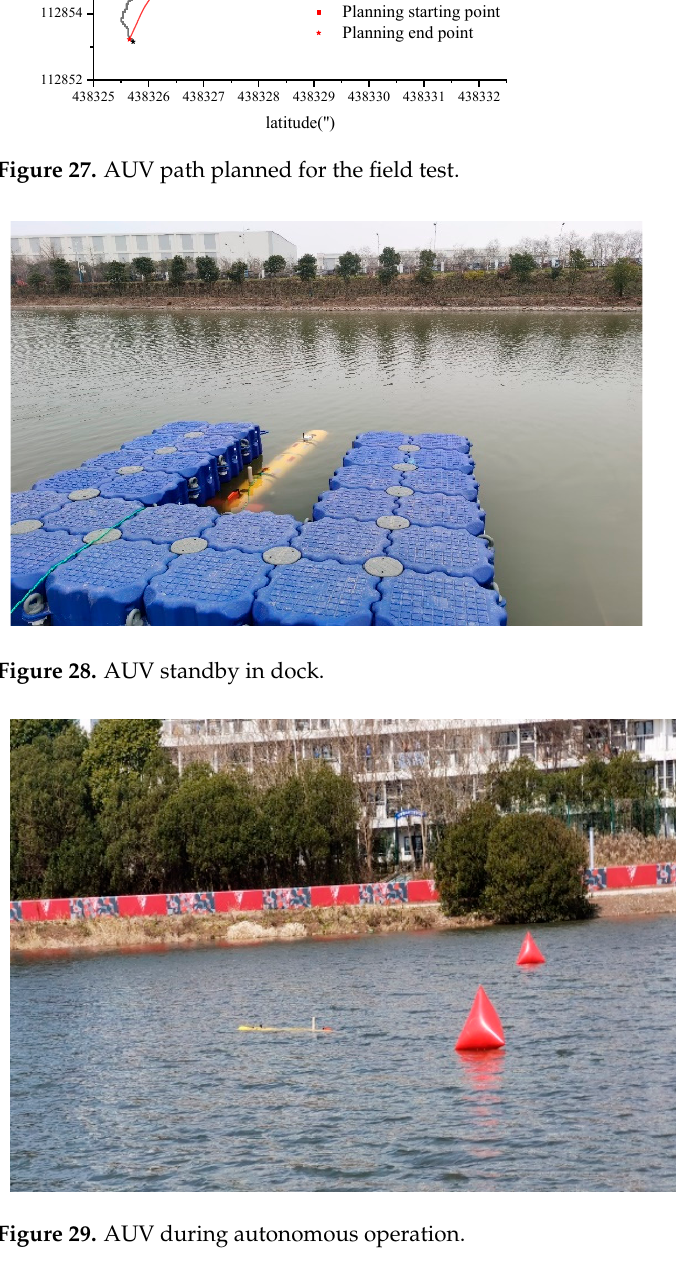
Figure 29. AUV during autonomous operation.